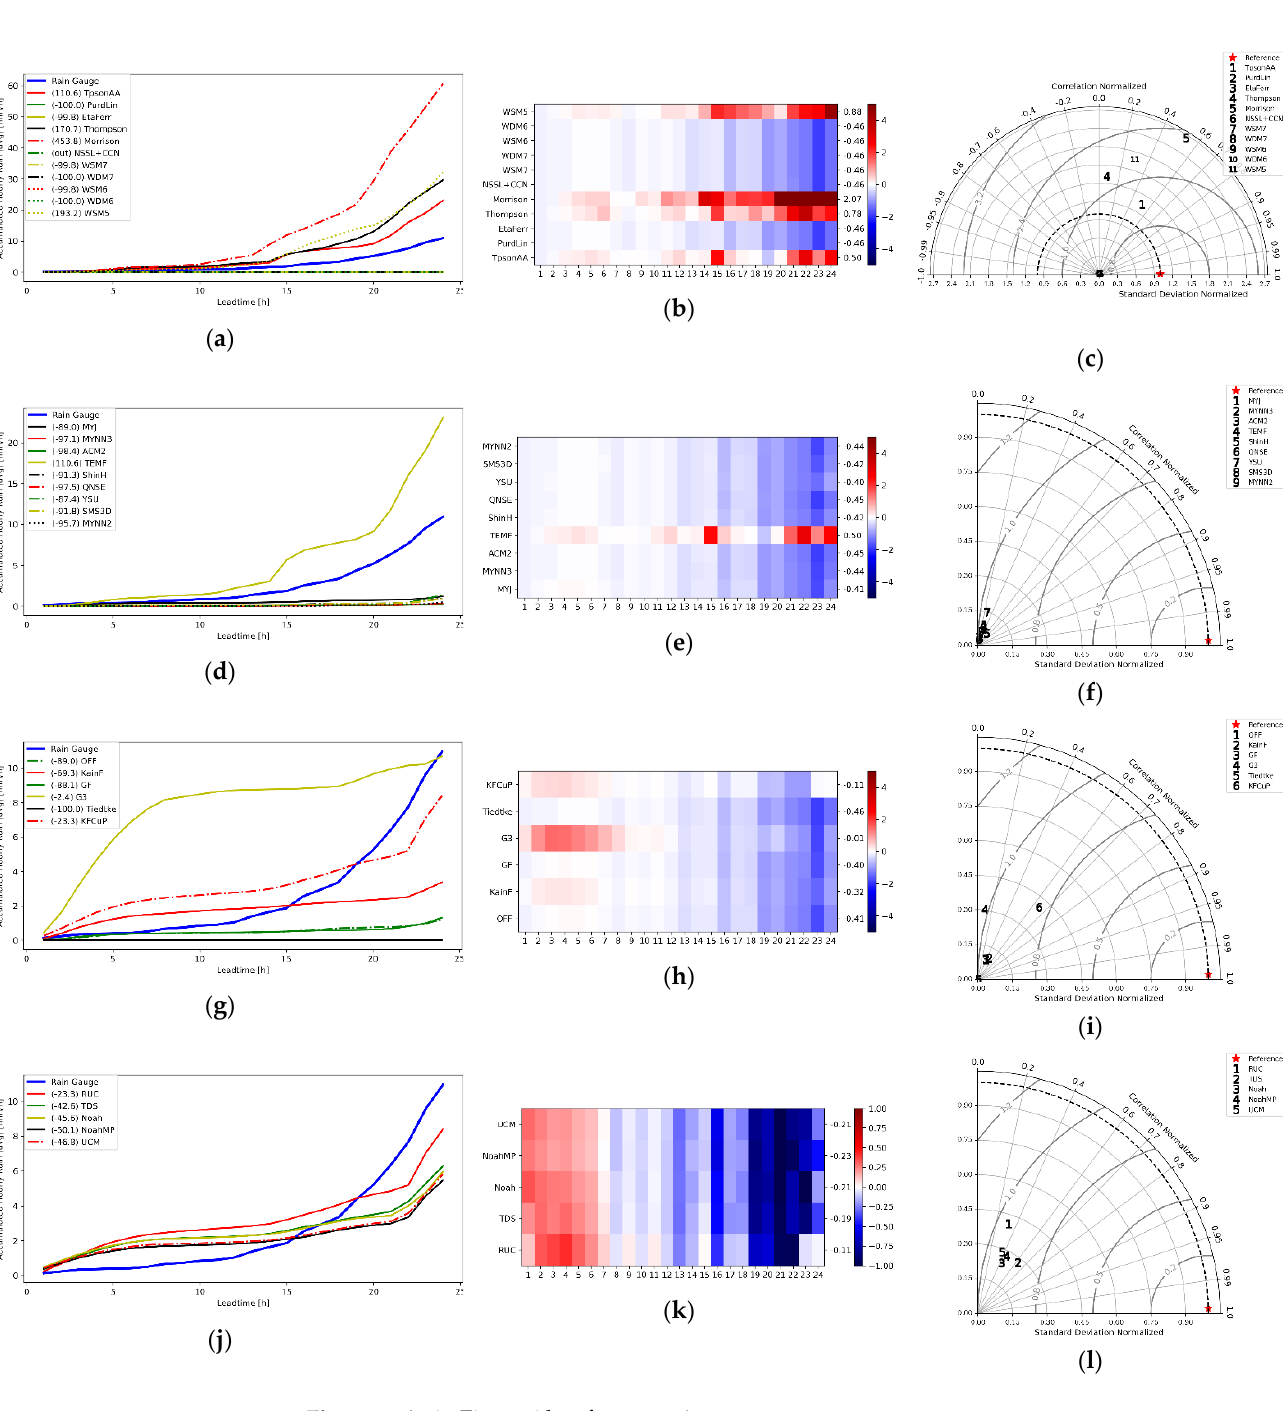
Figure 7. As in Figure 4 but for event 4.